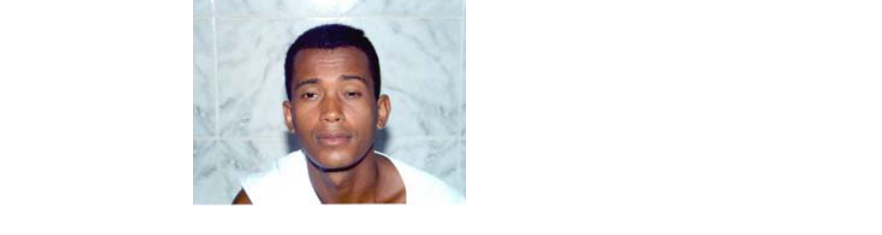
Figure 5: Palpebral ptosis is a prominent aspect in envenoming by snakes of the Crotalus genus. This patient was observed during this study.